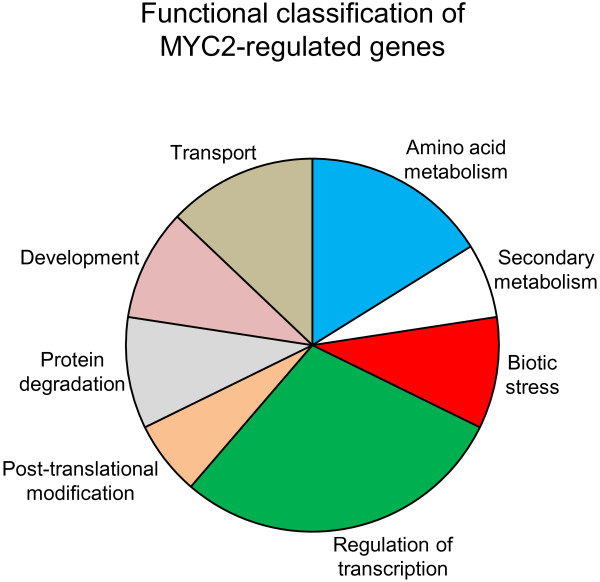
Transcriptional regulation by MYC2 transcription factor. Rosette leaves (n=3) were collected from WOS-induced (1 h) EV and MYC2-VIGS N. attenuata plants for microarray analysis. After pre-processing the raw data, genes whose expression changed significantly among the genotypes were identified using Significance Analysis of Microarrays (SAM) package and functional annotation was performed on Blast2Go. Pie chart depicts the functional categories of MYC2-regulated genes in N. attenuata.